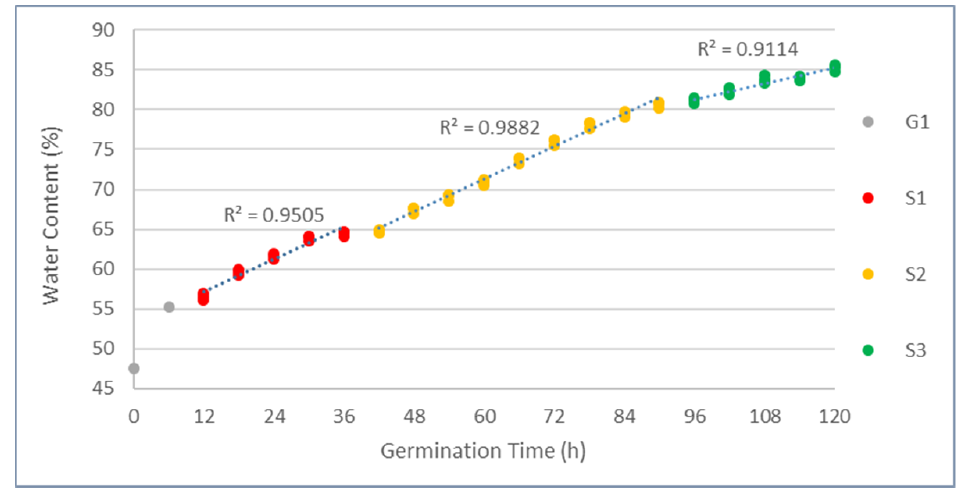
Figure 1. Water content plot of mung bean sprout in the function of germination time. Table 1. Water content, pH, and conductivity values of mung bean